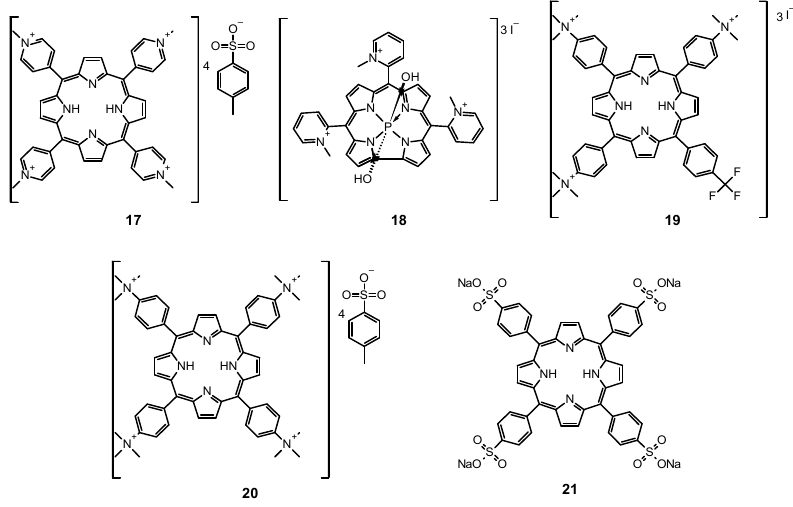
Figure 6. Chemical structures of 17–21.